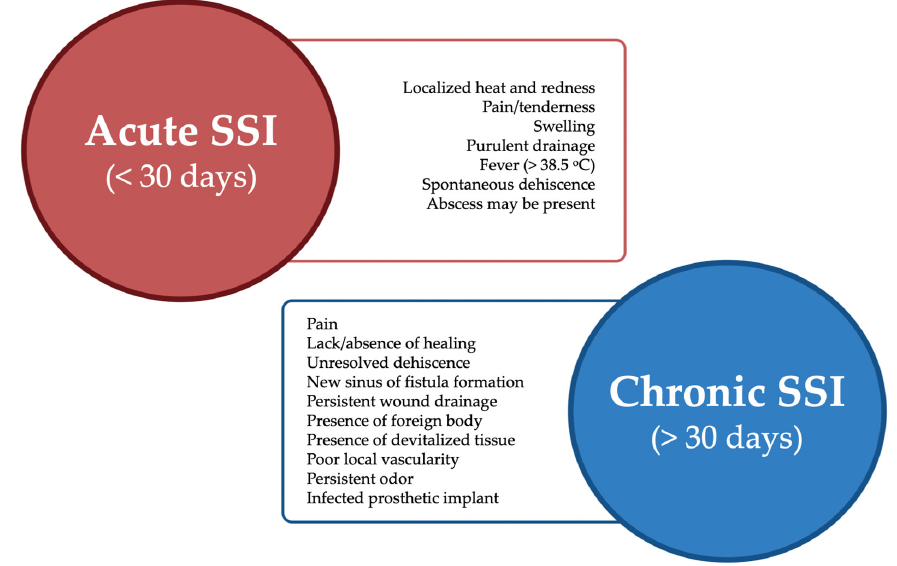
Figure 3. Major differences between acute and chronic SSIs.